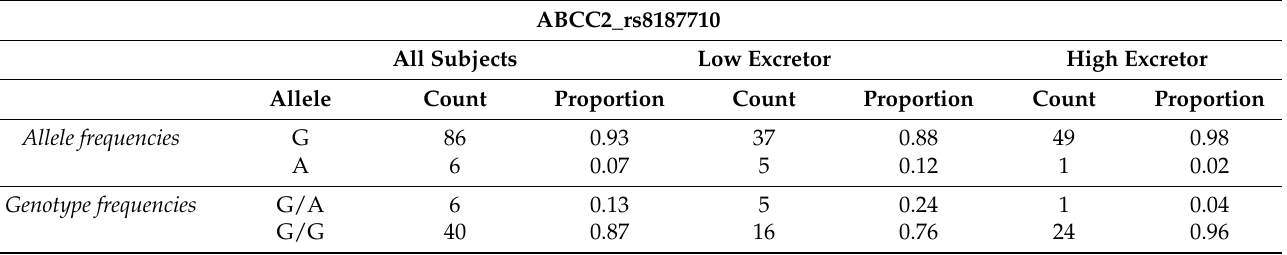
Table 3. Genotypes and allele frequencies of ABCC2_rs8187710 polymorphism in studied